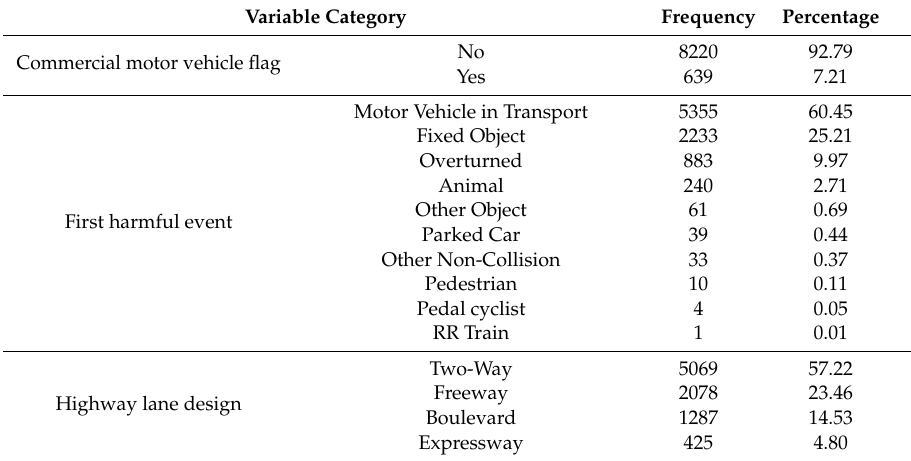
Table A1. The descriptive of the collected teen driver